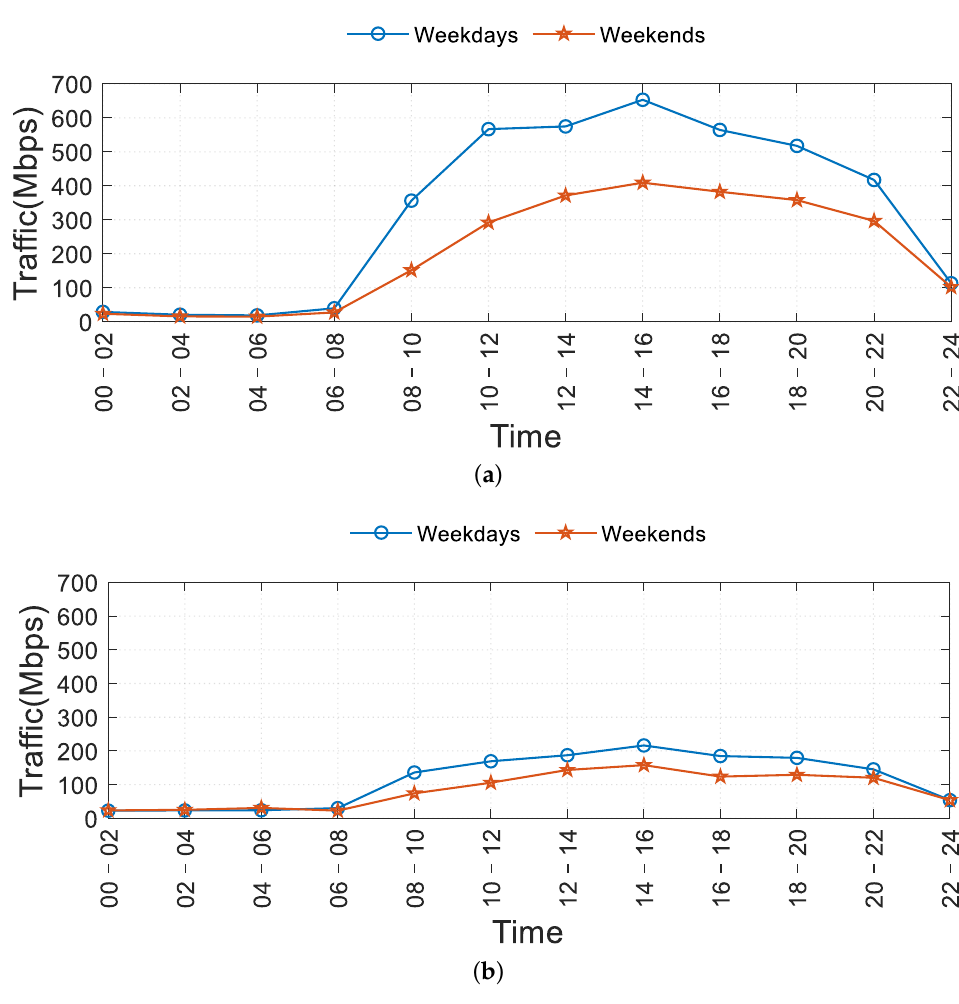
Figure 3. IPv6 downstream traffic patterns of weekdays and weekends. ( a ) Downstream traffic patterns in DHU. ( b ) Downstream traffic patterns in